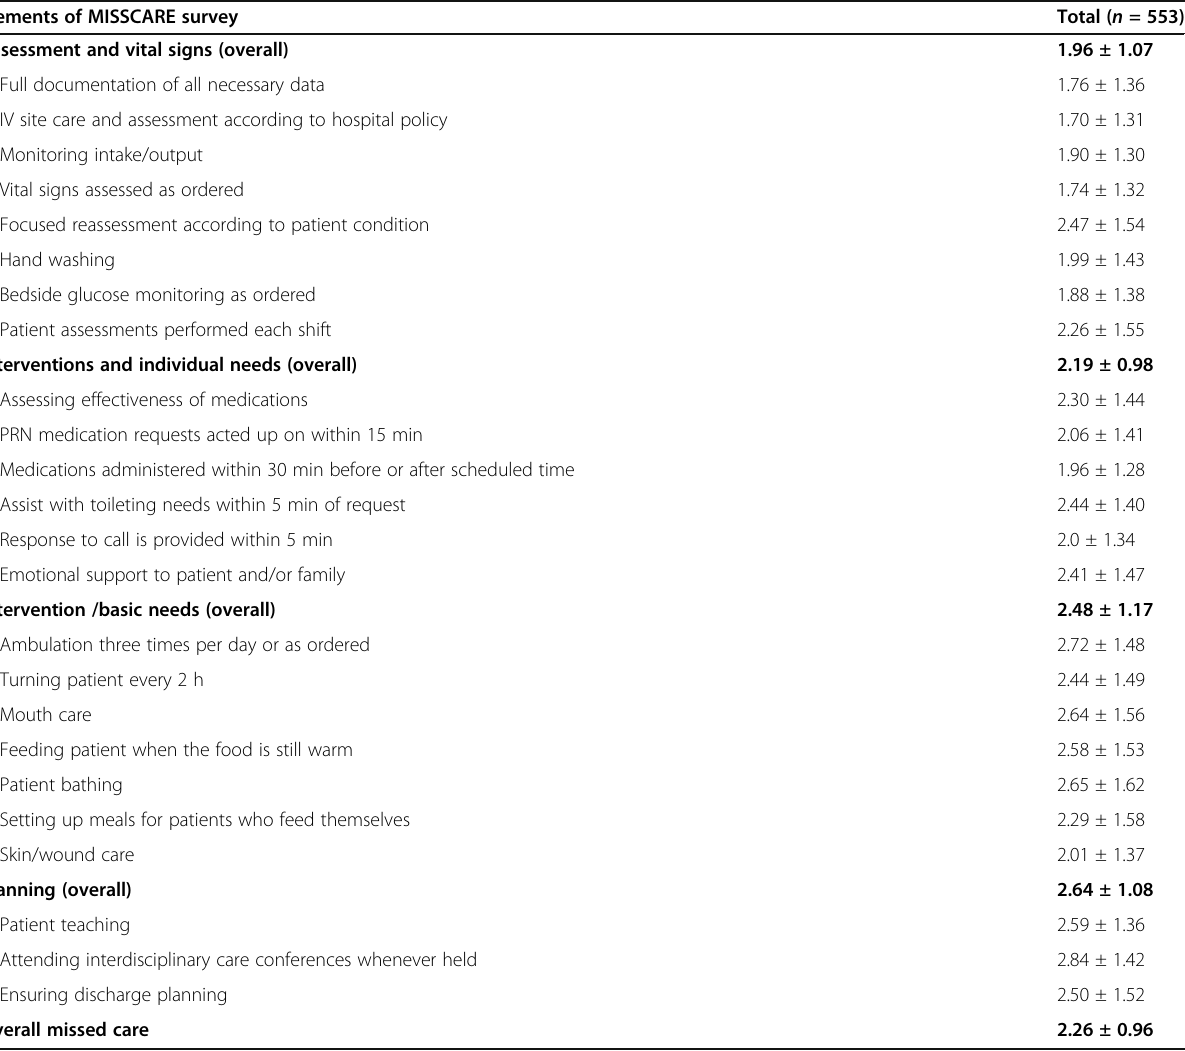
Table 1 Mean scores of missed nursing care among inpatient nurses in a teaching hospital in Alexandria, Egypt Elements of MISSCARE